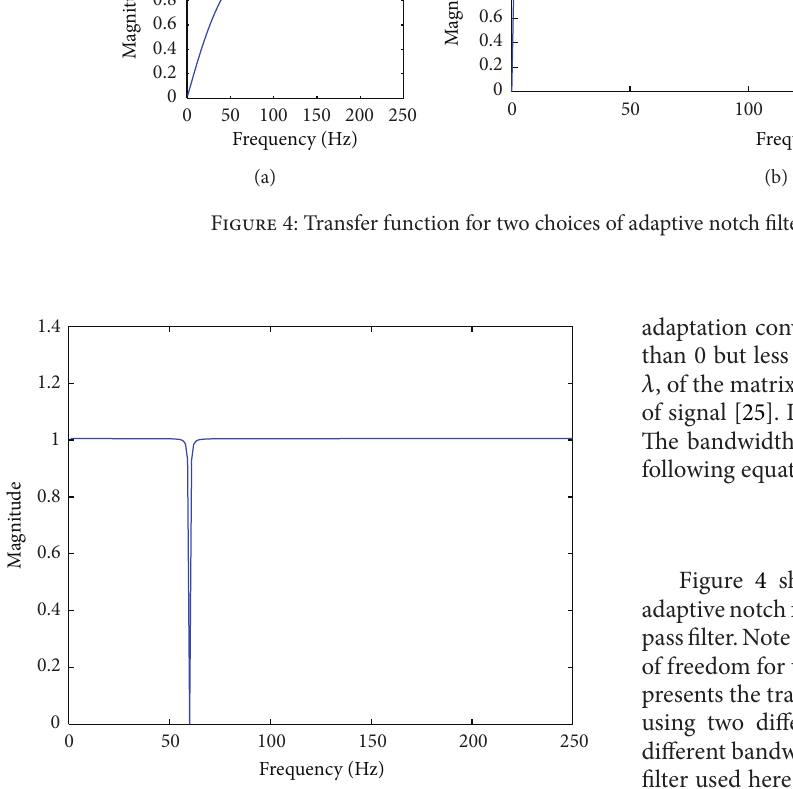
Figure 5: Transfer function of the adaptive notch filter around